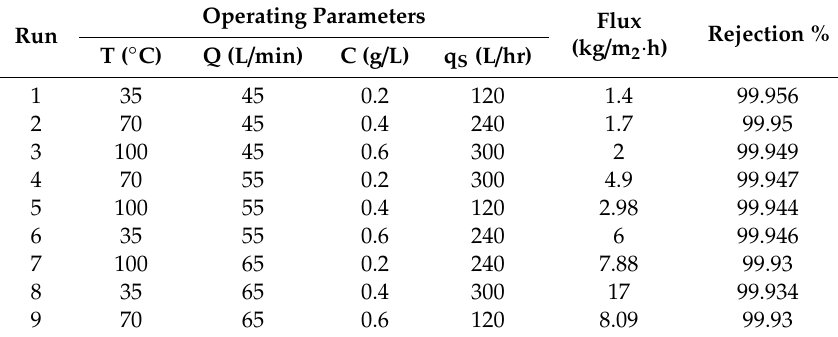
Table 5. Taguchi L 9 (3 4 ) OA, and result of experiments for Prepared membrane.